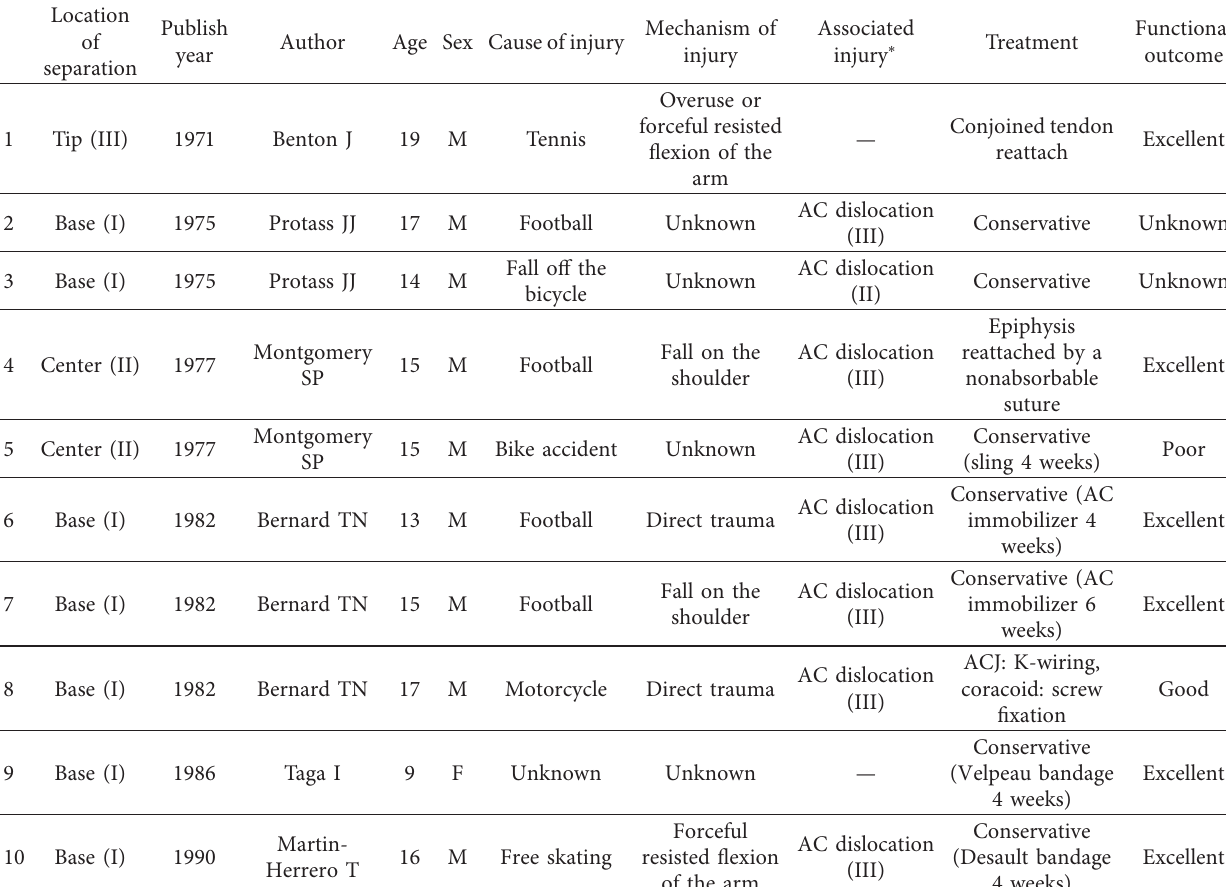
Table 2: Characteristics of patients with epiphyseal separation of the coracoid process identified from the literature review. Location of